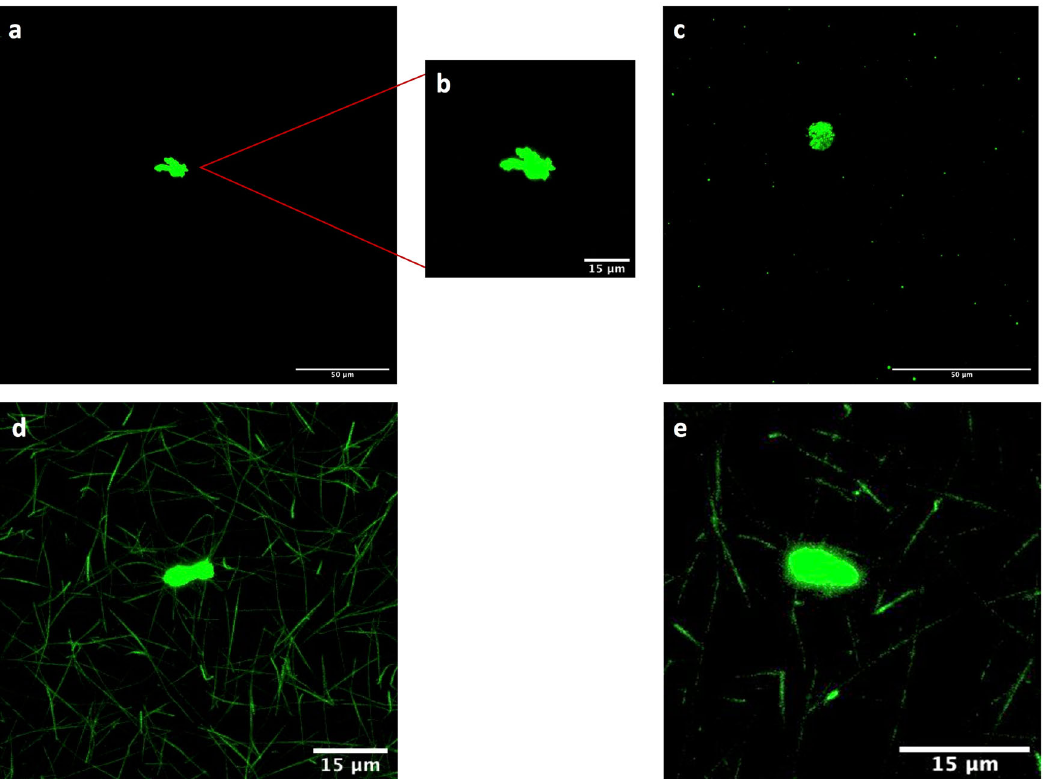
Fig. 3 Aggregates in plasma and plasma clots from a PE patient after double centrifugation. Blood samples were centrifuged twice in succession at 2500× g for 10 min each time. Aggregates were present in the double-centrifuged plasma prior to clotting ( a – c ). Zoom-in on aggregate of around 15 μ m in length (surface area ~175 μ m 2 ) ( b ). Aggregates embedded in the fi brin network after clotting with thrombin and calcium ( d , e ). Alexa Fluor 488 labelled fi brinogen is shown green. Scale bars are 50 μ m in a and c and 15 μ m in b , d , and e